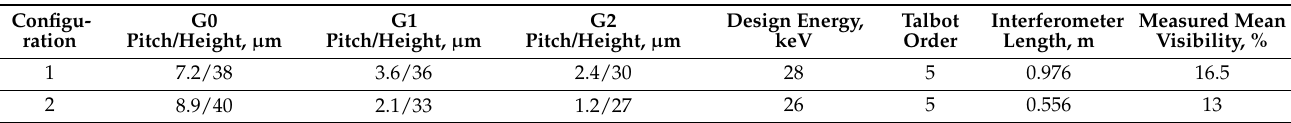
Table 2. Different tested grating configurations. (Fabrication of G0 gratings is described in [16]. Details on the measurement setup are presented